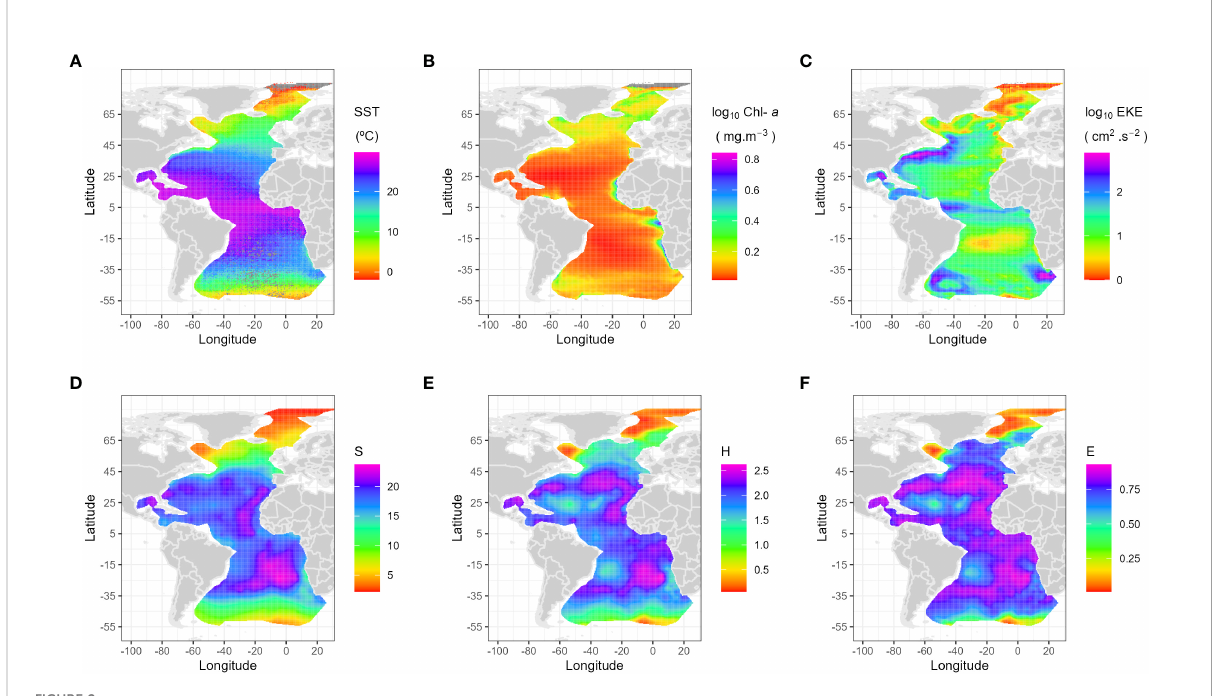
FIGURE 2 Geographic distribution of the main oceanographic drivers (annual averaged decadal scales), (A) Sea Surface Temperature (SST, °C), (B) Chlorophyll- a (CHL, mg m -3 ), (C) Eddy Kinetic Energy (EKE, cm 2 s -2 ) with the latter two presented on logarithmic scale, and geographic distribution of the three diversity indices, interpolated using kriging, (D) species richness (S), (E) Shannon diversity (H) and (F) for evenness